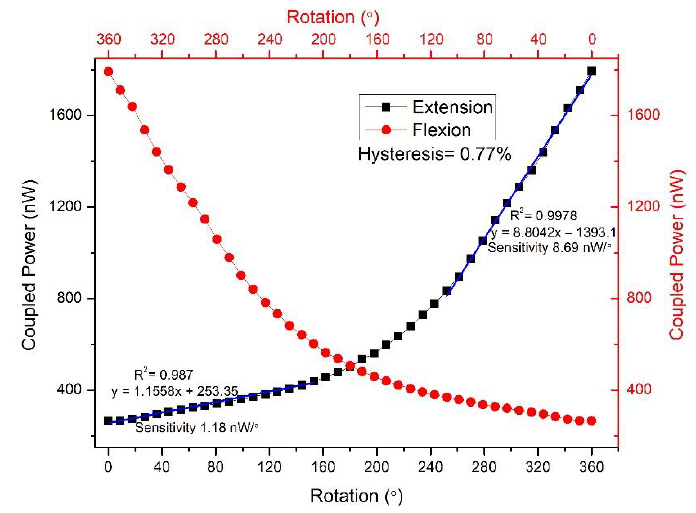
Figure 7. The rotational sensor response with optimized sensitivity and hysteresis.